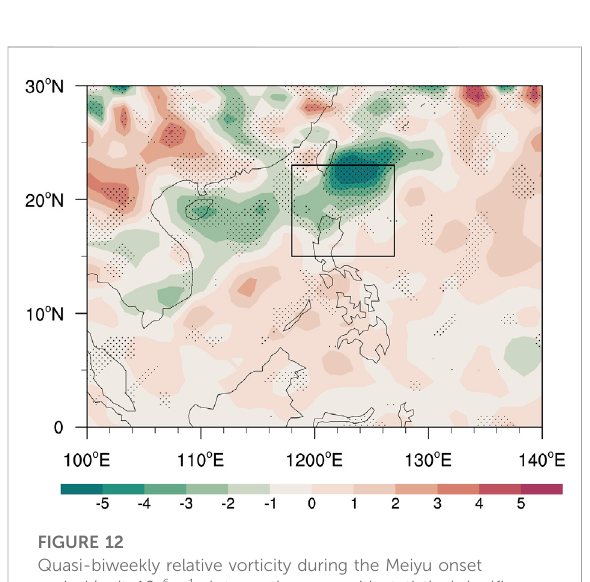
FIGURE 12 Quasi-biweekly relative vorticity during the Meiyu onset period (unit: 10 − 6 s − 1 ; dots are the areas with statistical signi fi cance exceeding the 95% level).